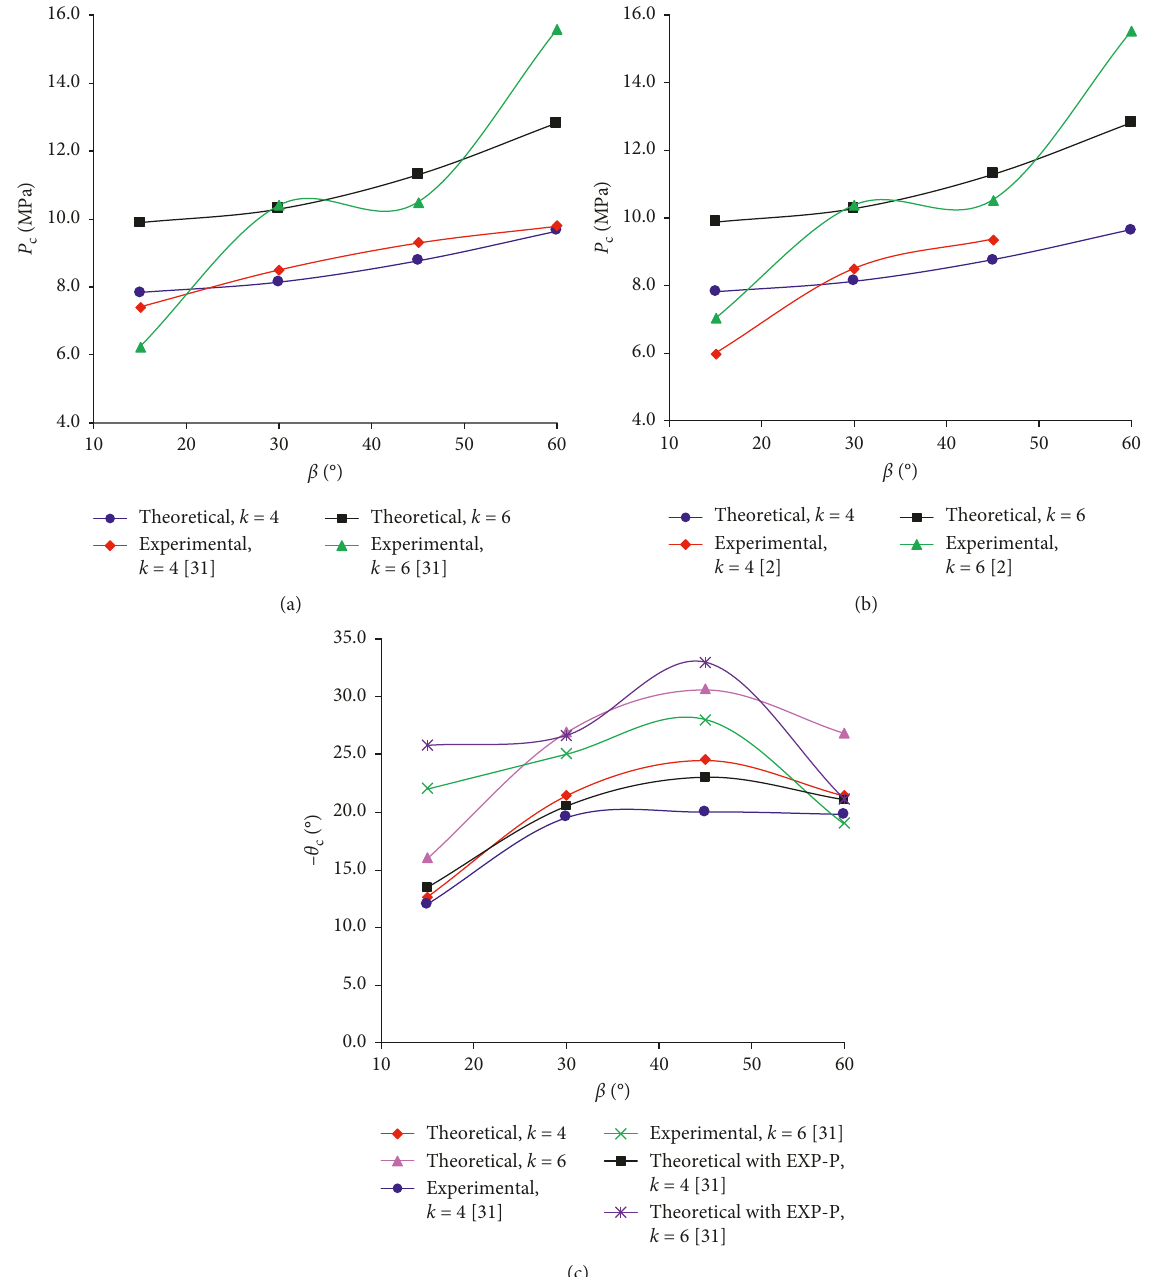
Figure 7: Comparison of the critical water pressure and critical initiation angle obtained by using the theoretical model and the ex- perimental tests obtained from Chen et al. [2] and Jin